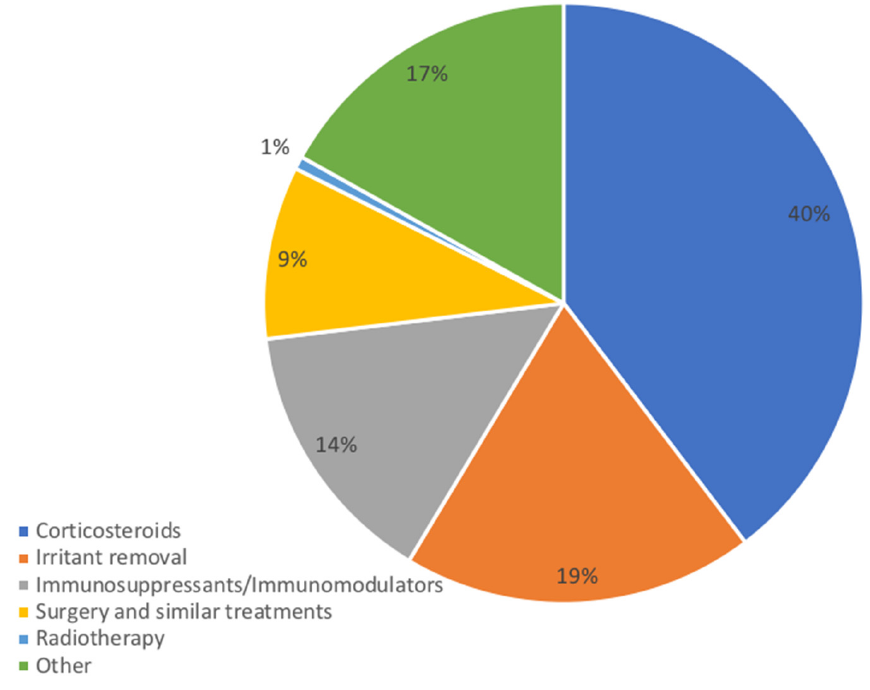
Figure 4. Therapeutic strategies for